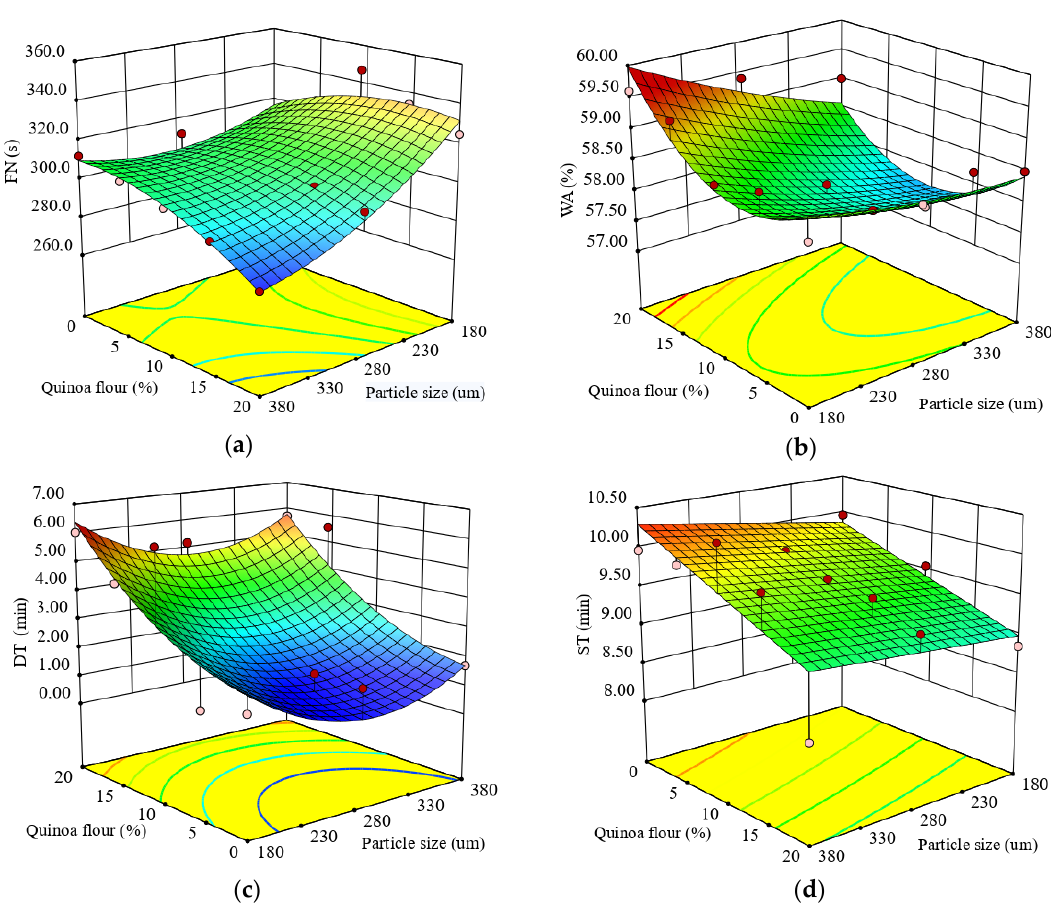
Figure 1. Response surface graph for combined effects of quinoa flour particle size and levels added in refined wheat flour on: ( a ) Falling number index and Mixolab parameters during dough development stage: ( b ) water absorption (WA), ( c ) development time (DT), ( d ) dough stability (ST).